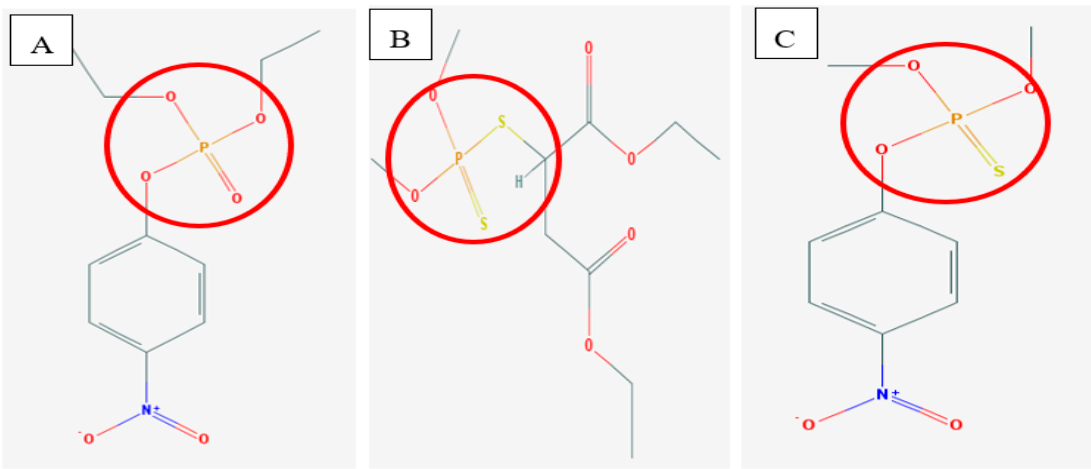
Figure 1. Three major groups of organophosphate compound. ( A ) Phosphotriester (paraoxon), ( B ) thiophosphotriester (methyl parathion), and ( C ) phosphorothiolester (Malathion). The red circles embody the differences between the OP-S compounds. The structures were adopted from Pubchem.